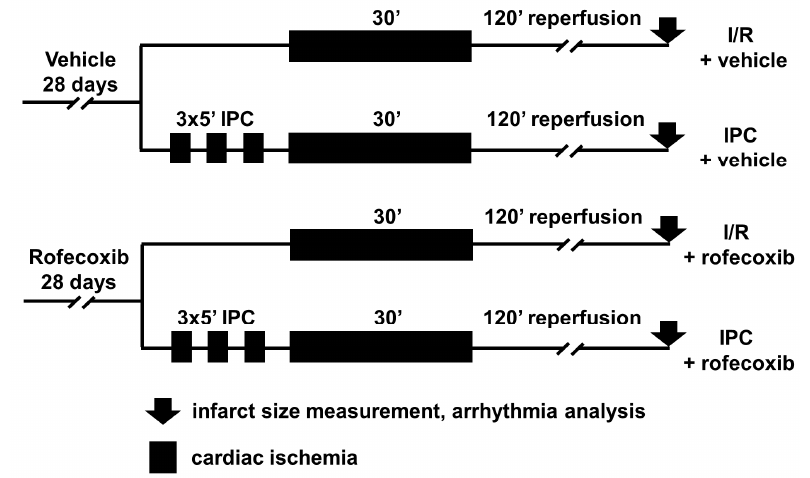
Figure 1. In vivo ischemia/reperfusion (I/R) injury study protocol: male Wistar rats treated with rofecoxib (5.12 mg kg − 1 /day) or vehicle for 4 weeks were subjected to I/R of the left anterior descending (LAD) coronary artery or to ischemic preconditioning (IPC) elicited by three cycles of 5 min. LAD occlusion and 5 min. reperfusion before the index ischemia.